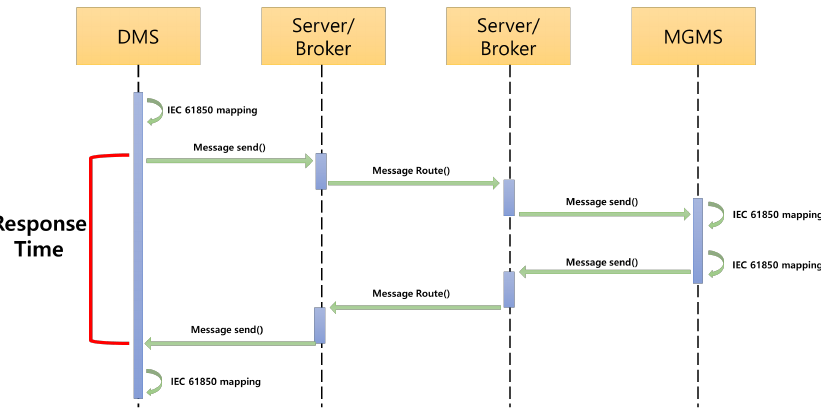
Figure 15. Sequence diagram to measure the response